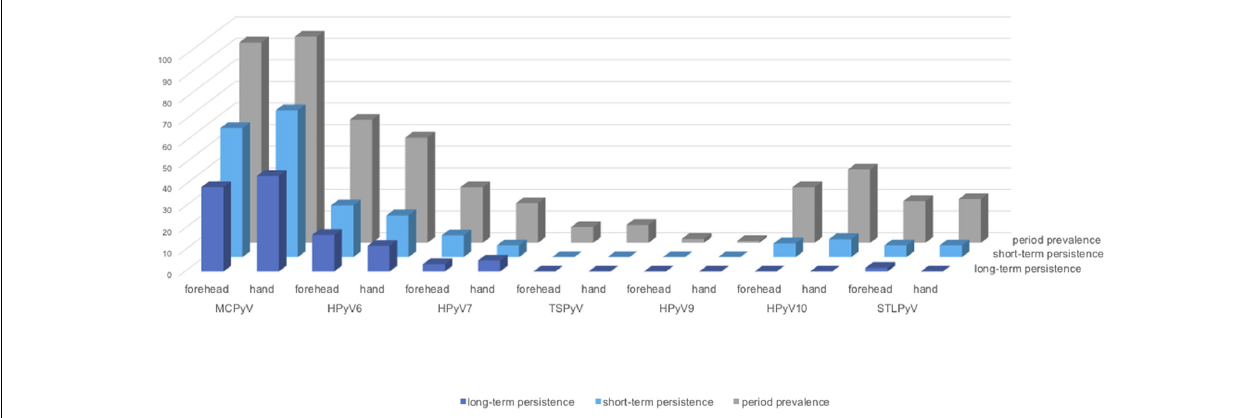
FIGURE 3 | Human polyomavirus period-prevalence, short-, and long-term persistence by collection site. Y-axis: prevalence in percentage (%). Dark-blue bars: long-term persistence; light-blue bars: short-term persistence; grey bars: period prevalence